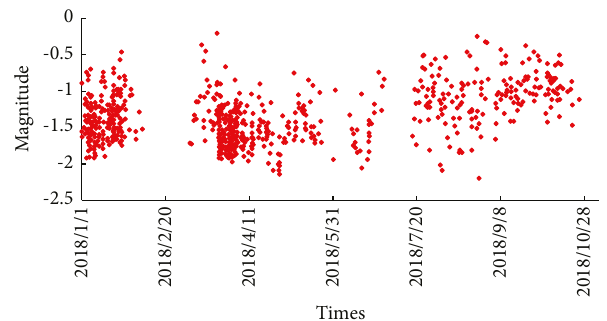
Figure 7: Relationship between magnitude and time of micro- seismic events in the traffic